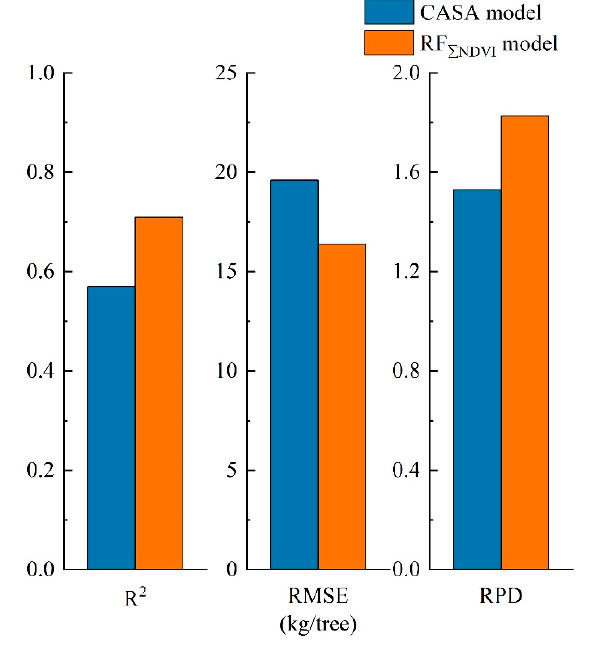
Figure 8. Accuracy comparison of the results obtained by the RF ∑ NDVI model and the CASA SR model.